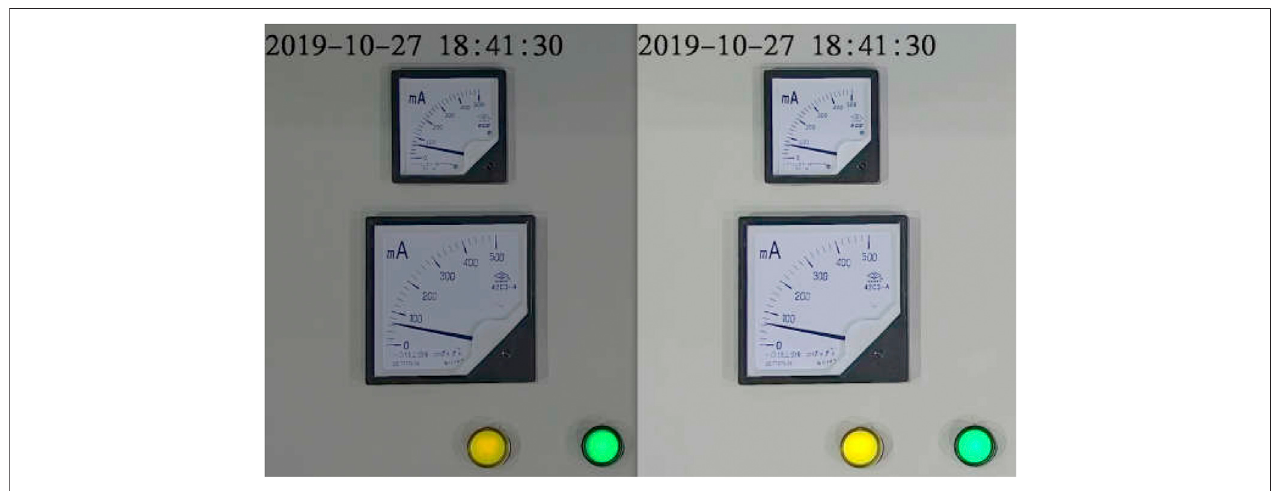
FIGURE 5 | Histogram normalization transformation effect comparison, the left is the pre-processing image, and the right is the fi nished effect image. The brightness of the image was obviously optimized, while the contrast was increased, which produced clearer details in the darker areas.